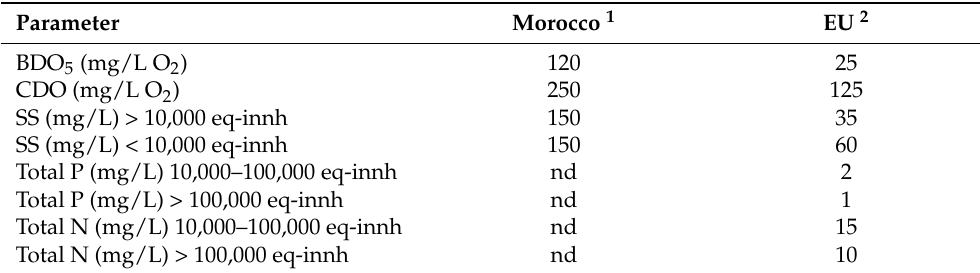
Table 1. Some quality standards of the Moroccan and European Union (EU) wastewater treatment regulations.